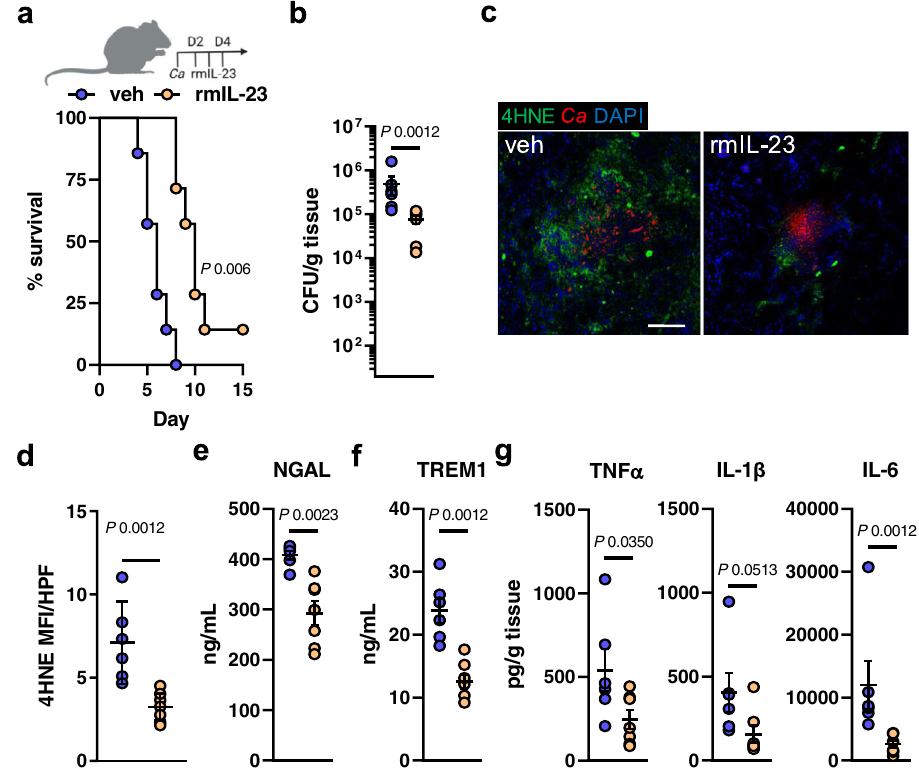
Fig.8|RecombinantIL-23treatmentreducesferroptosisandimprovesdisease outcomes during C. albicans infection. a (Top) IL-23 treatment scheme